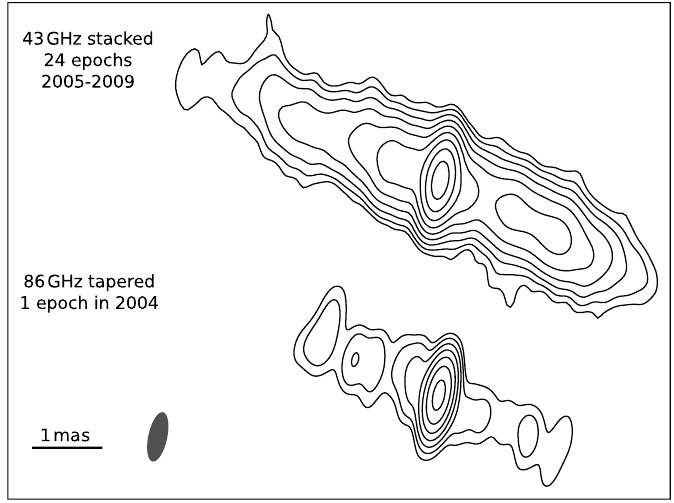
Figure 4. Top : stacked (multi-epoch) 43 GHz image; Bottom : tapered 86GHz image, setting more weight to the shorter baselines. Both maps are restored with the common beam for all 24 analyzed 43GHz epochs. Both maps show one central bright feature. Verifying this as the dynamic center at 43GHz pinpoints the location of the central supermassive black hole (SMBH) at